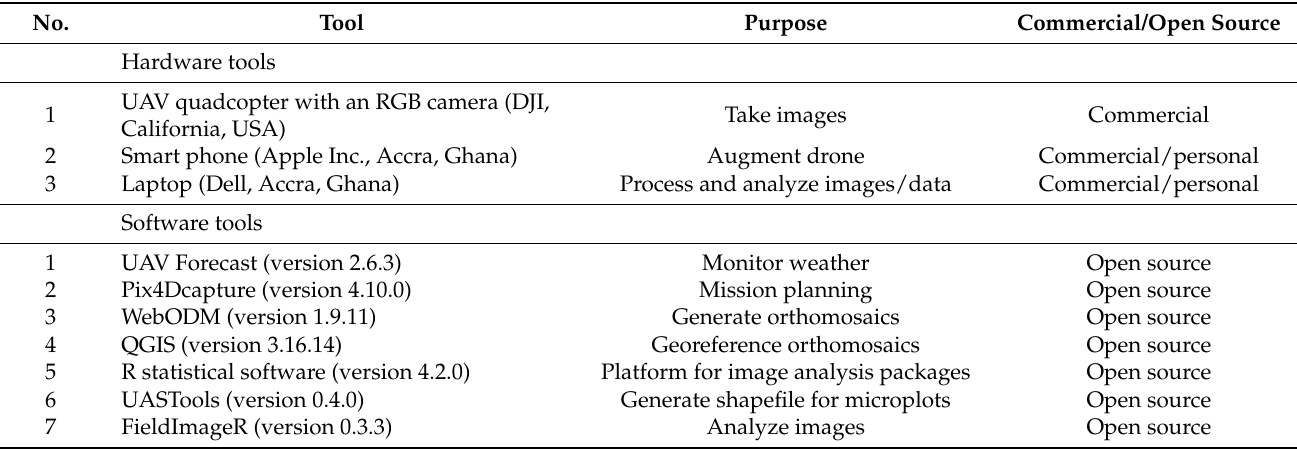
Table 2. Hardware and software tools used in this